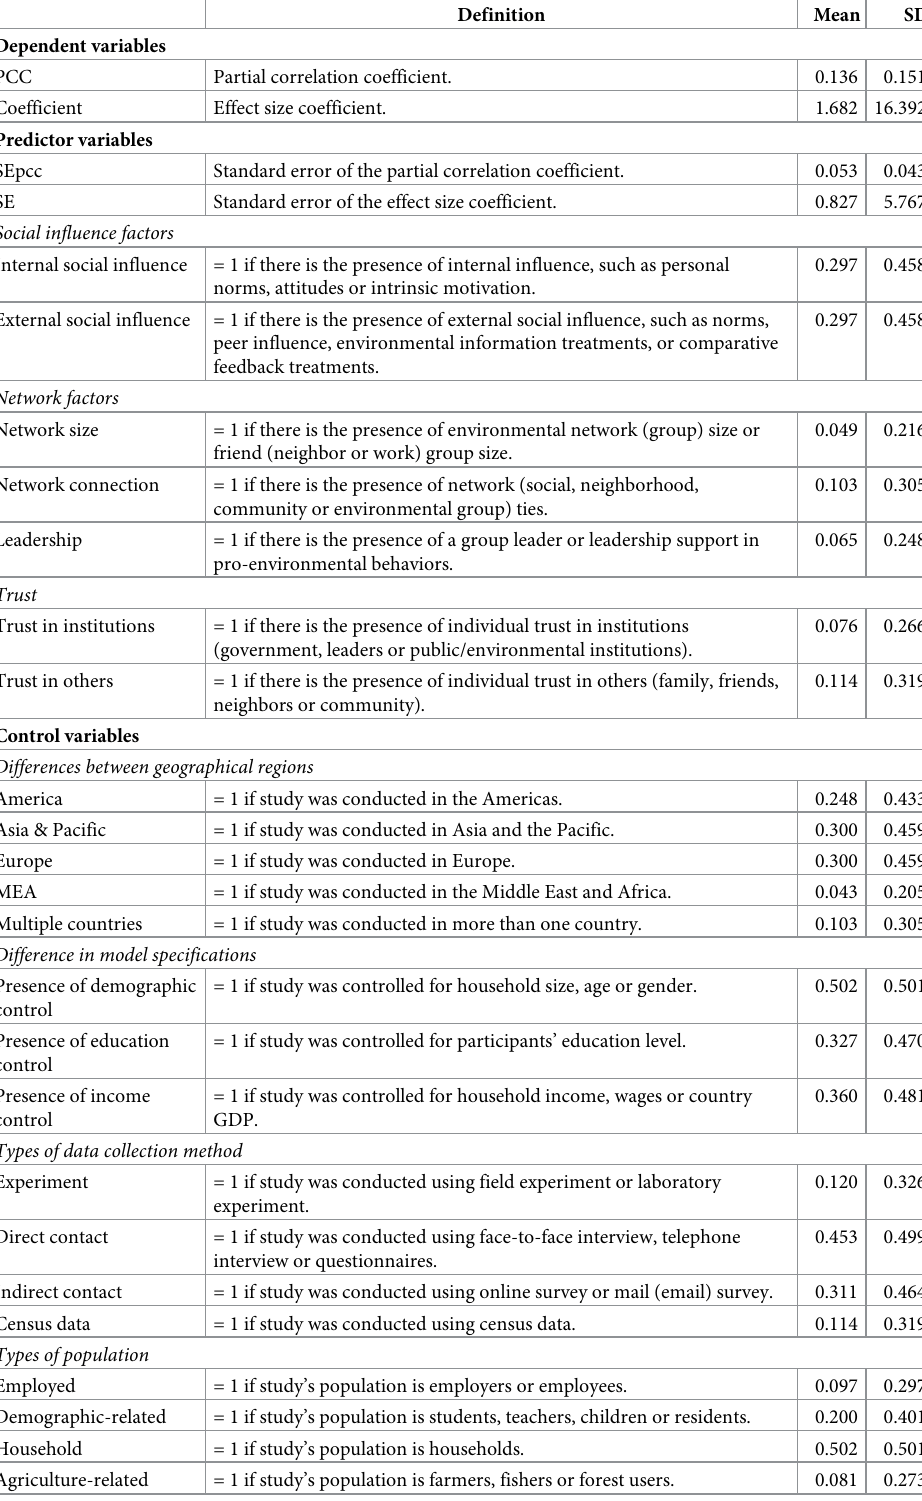
Table 2. A brief summary of the descriptive